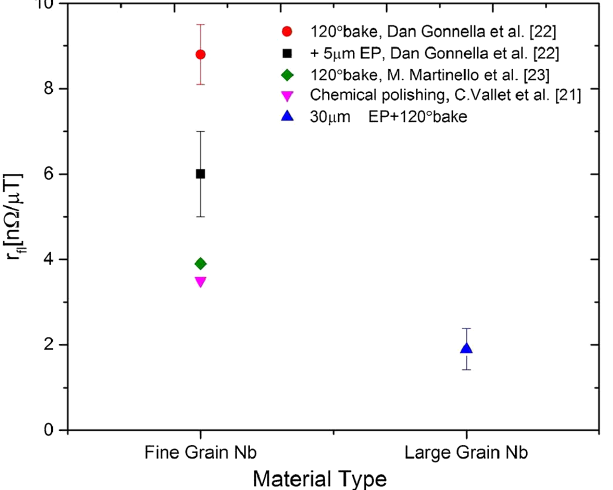
FIG. 6. The sensitivity r large-grain niobium with different surface treatments.